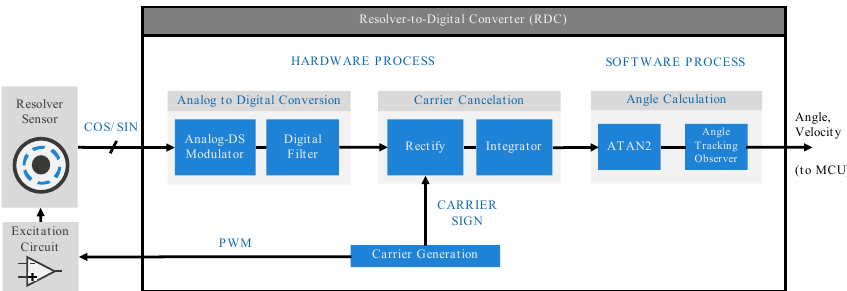
Figure 3. Exemplary illustration of a resolver rotor position signal processing system.